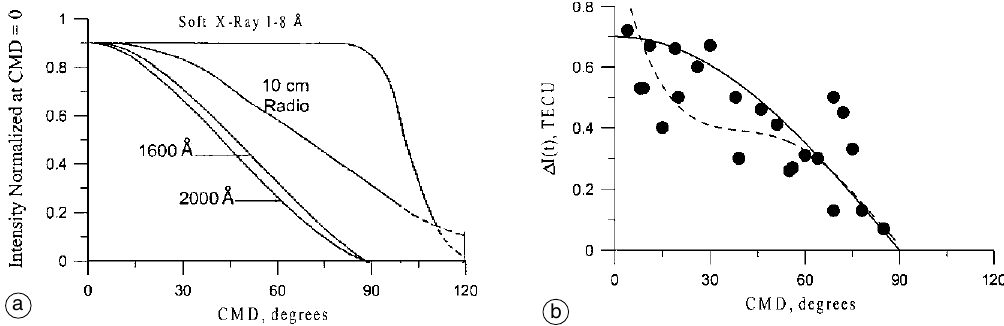
Fig. 6a,b. Average central meridian distance dependence based on (Mosher, 1979) for X-Ray (Riddle, 1969) and (Aschwanden et al. , 1999) for F10, and (Samain, 1979) for the UV (a); modeling results on the SFD occurrence probability at the time of the solar flare as a function of the CMD (dashed lines) (Donnelly, 1976), values of the mean amplitude of the TEC response in the ionosphere to solar flares (dots), and cos(CMD) fitting curve for solar flares in the X-ray range M 2.0 – M 5.7 (solid lines) (b).